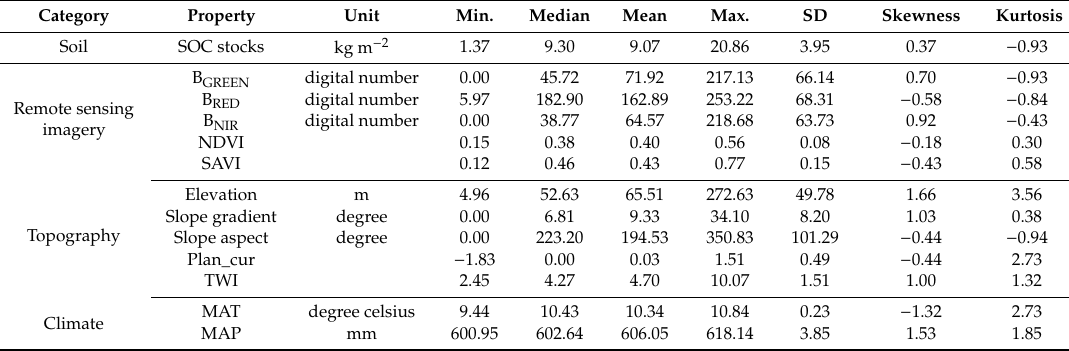
Table 1. Summary statistics of soil organic carbon (SOC) stocks (0–30 cm) and environmental variables at samples